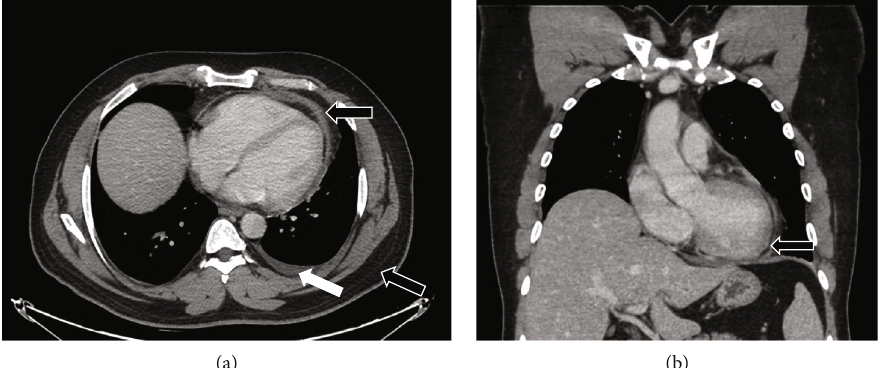
Figure 2: (a) The axial image and (b) the coronal image of the CT scan of the chest post administration of IV contrast showing di ff use pericardial thickening and pericardial fat stranding (black arrow) with small left pleural e ff usion (white